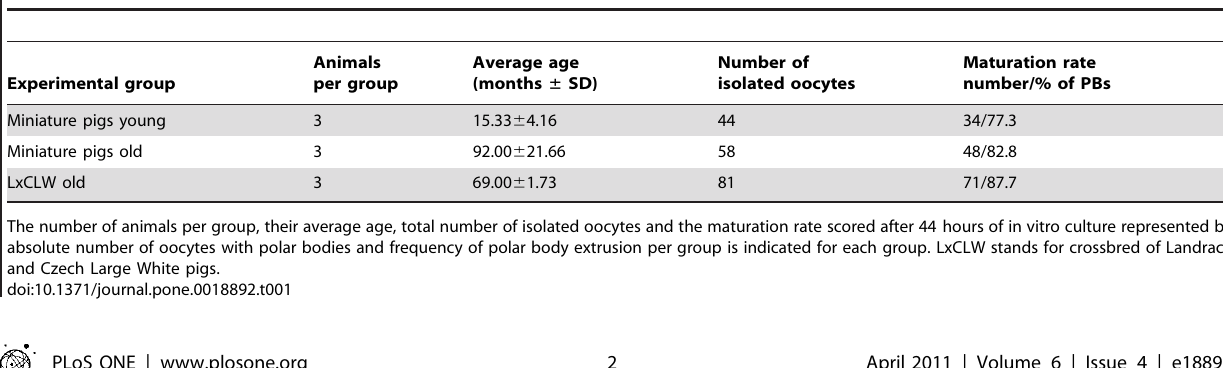
Table 1. In vitro maturation of porcine oocytes isolated from various experimental